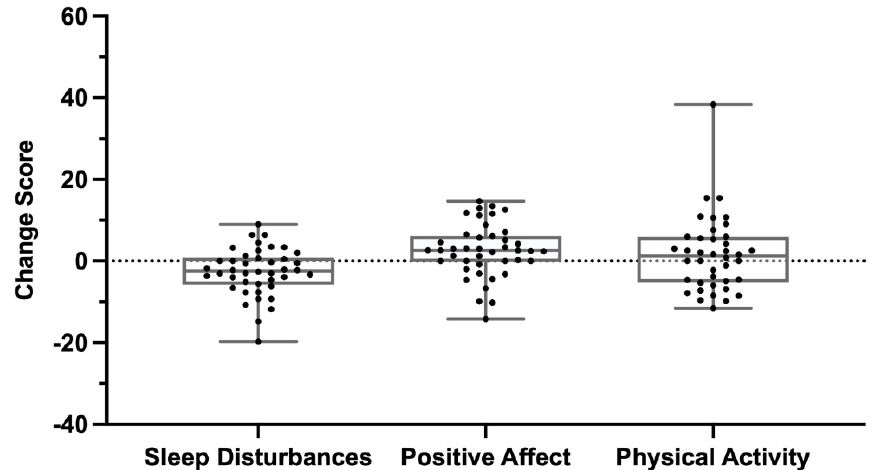
Figure 5. PROMIS parent proxy change scores from baseline to one month of Trexo use.